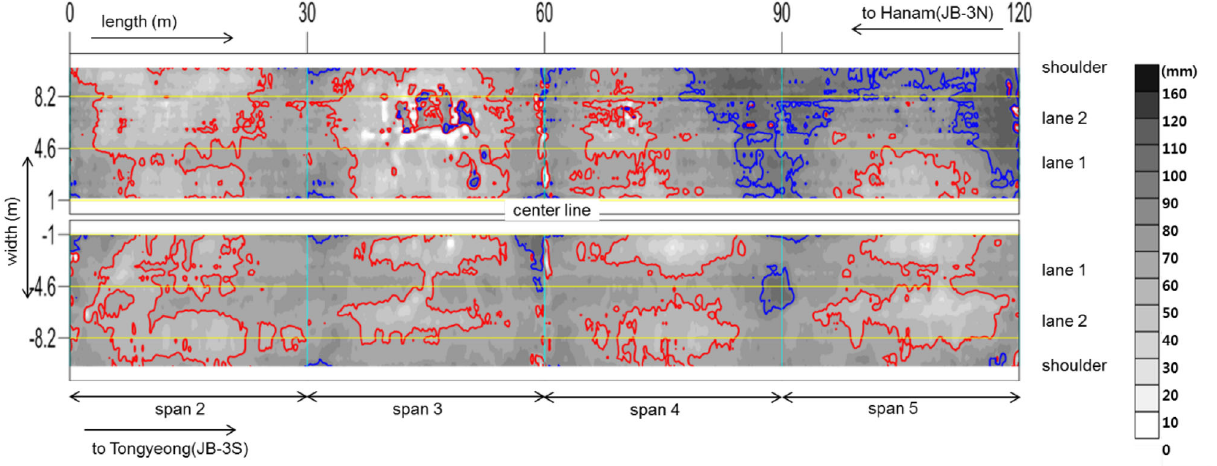
Fig. 13 Distribution of cover thickness of top rebar; red and blue lines represent 60 mm and 90 mm thickness, respectively.